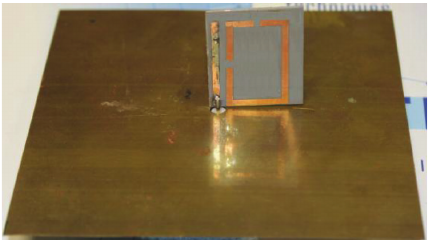
Figure 6: Photo of the realized prototype of the single NFRP element reconfigurable antenna.